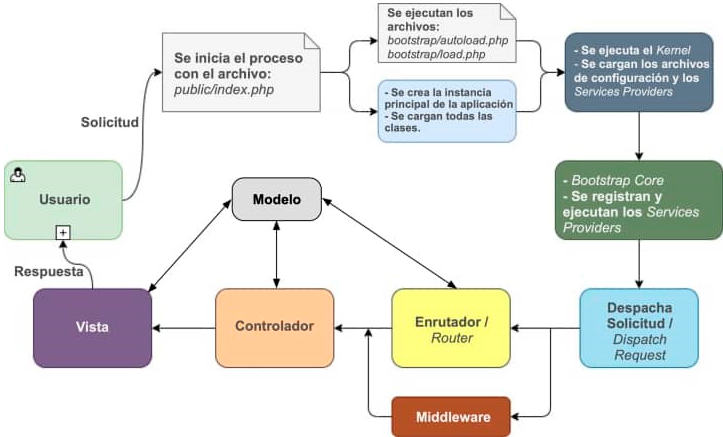
Figure 4. Laravel lifecycle. Figure 4. Laravel